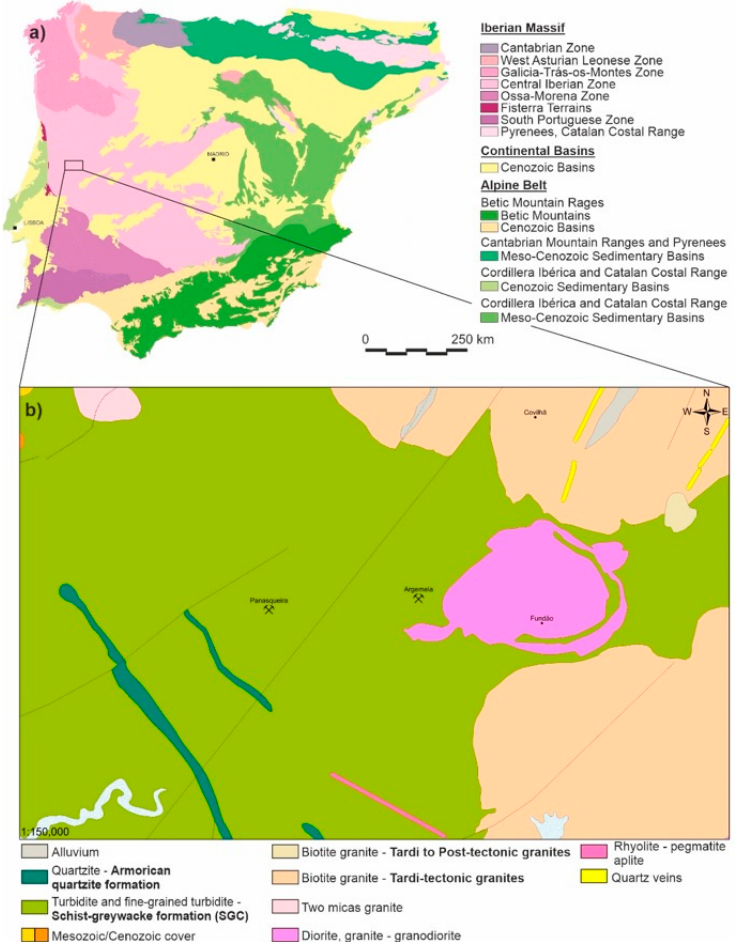
Figure 1. Location and regional setting of Argemela. ( a ) Map of the Iberian Massif showing the main geological units, based on a 1:1,000,000 scale geological map [29]. ( b ) Regional geological map based on a 1:1,000,000 scale geological map [29].